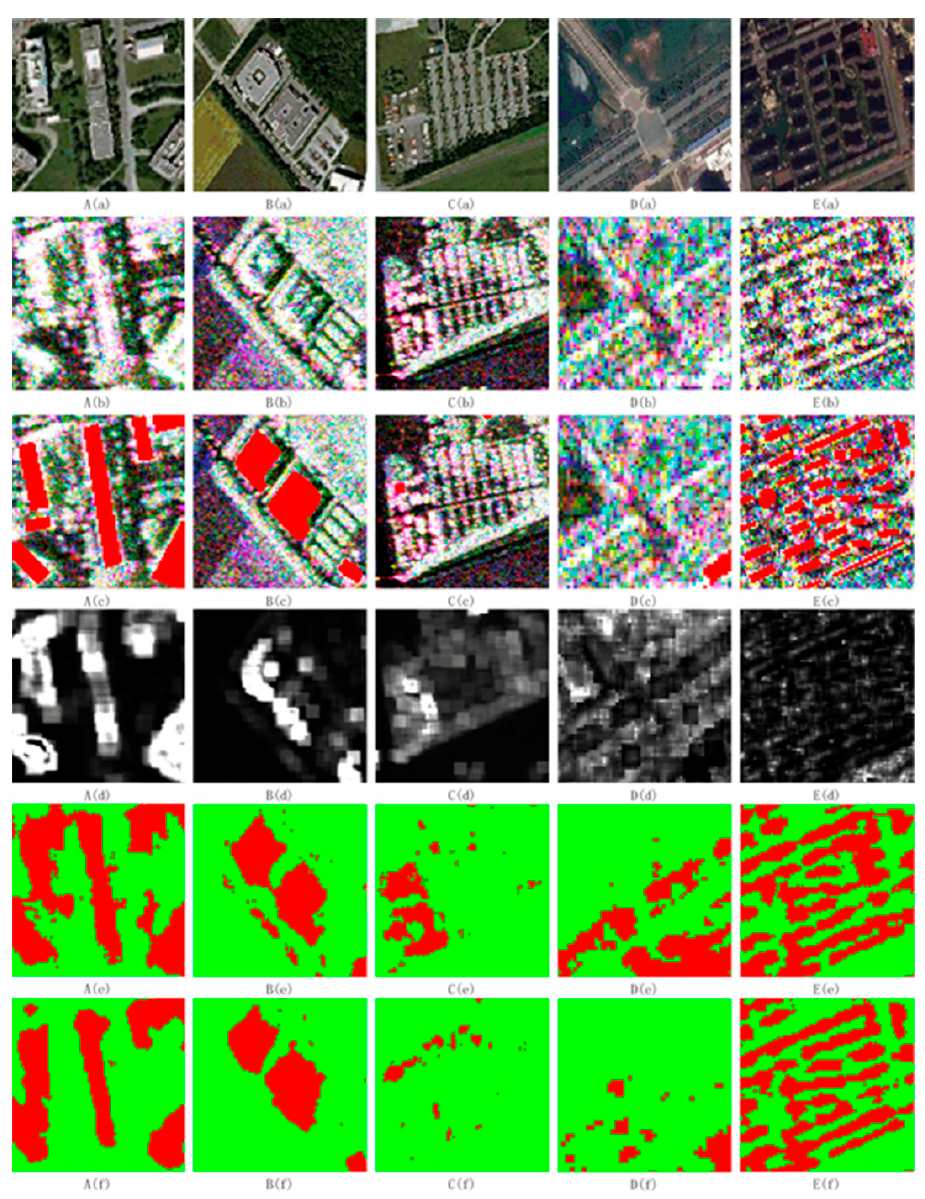
Figure 7. Buildings and similar building features in the PolSAR image ( A , B , C ) images from ESAR. Group ( D ) images from GF-3 and Group ( E ) images from RADARSAT-2. Where ( a ) is the optical image, ( b ) is PauliRGB, ( c ) is the mask of the real building distributed on PauliRGB (red area), and ( d ) is the G 0 statistical texture parameter. ( e ) Classification results obtained by using only PauliRGB as CNN input training, in which red is a building, green is a non-building, and ( f ) is a classification obtained by adding a G 0 statistical texture parameter to PauliRGB as a CNN input training, in which red is a building and green is a non-building.